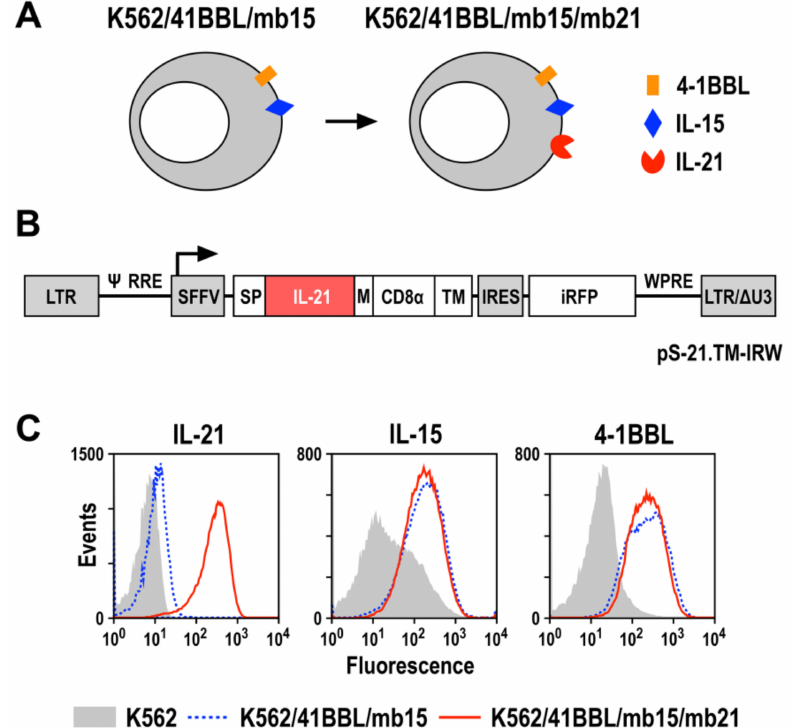
Figure 4. Genetically engineered K562 feeder cells for expansion of NK cells. ( A ) Schematic representation of K562 / 41BBL / mb15 and K562 / 41BBL / mb15 / mb21 feeder cells that express membrane-bound pro-NK factors 4-1BB ligand (4-1BBL), IL-15 (mb15), and IL-21 (mb21). ( B ) K562 / 41BBL / mb15 / mb21 cells were generated by transduction of previously described K562 / 41BBL / mb15 cells [12] with lentiviral vector pS-21.TM-IRW,whichencodesunderthecontrolofthespleenfocus-formingviruspromoter(SFFV),afusion of IL-21 linked via a flexible CD8 α hinge region to the transmembrane and truncated intracellular domain of CD28 (TM), followed by an internal ribosome entry site (IRES) and cDNA-encoding near-infrared fluorescent protein (iRFP) as a marker. SP, immunoglobulin signal peptide; M, Myc tag; LTR, HIV-1 5’ long terminal repeat; Ψ , HIV-1 packaging signal; RRE, HIV-1 Rev response element; WPRE, woodchuck hepatitis virus post-transcriptional regulatory element; LTR / ∆ U3, HIV-1 3’ LTR in self-inactivating (SIN) configuration. ( C ) After transduction, enhanced green fluorescent protein (EGFP)- and iRFP-expressing K562 / 41BBL / mb15 / mb21 cells (red solid line) were enriched by flow cytometric cell sorting and analyzed for surface expression of IL-21, IL-15, and 4-1BBL using specific fluorochrome-conjugated antibodies. Parental K562 cells (gray shaded area) and K562 / 41BBL / mb15 cells (blue dotted line) served as